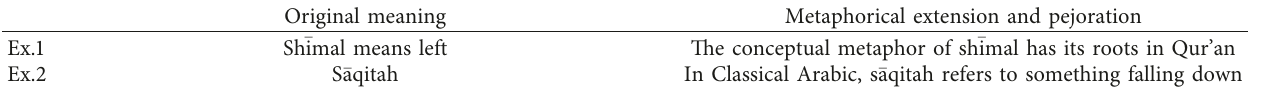
Table 3: Metaphorical extension of meaning and